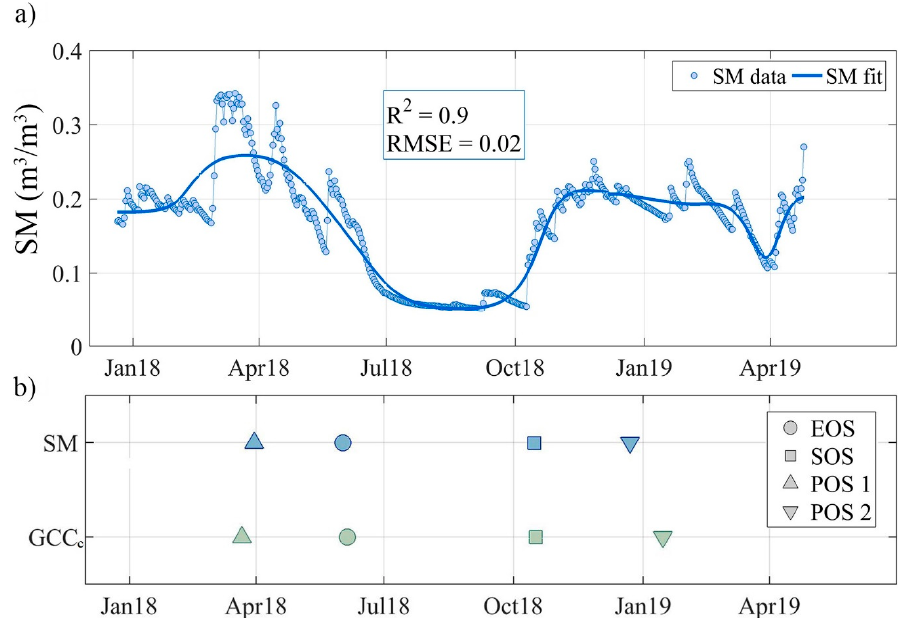
Figure 8. ( a ) Evolution of SM (raw data, fitted function and error) for the study period. ( b ) Comparison of the phenological dates of GCCc (green) and SM (blue) in period A.